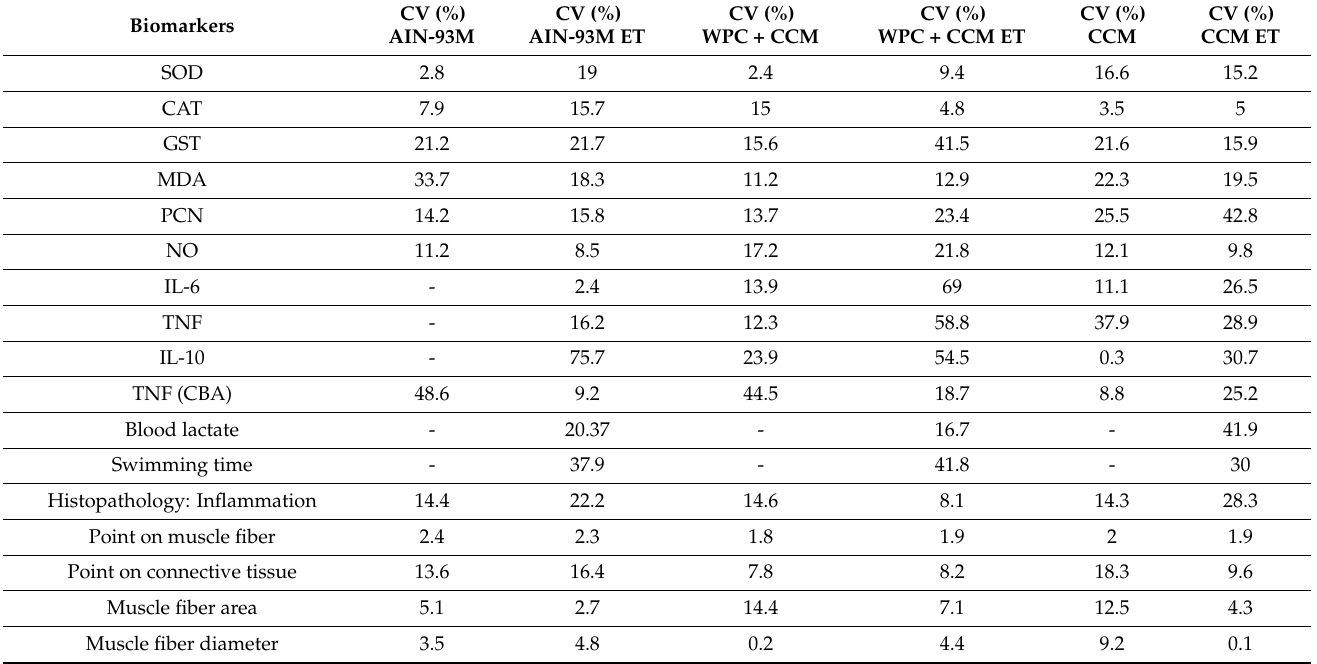
Table 3. Variability expressed as coefficient of variation (CV%), tabulated within different